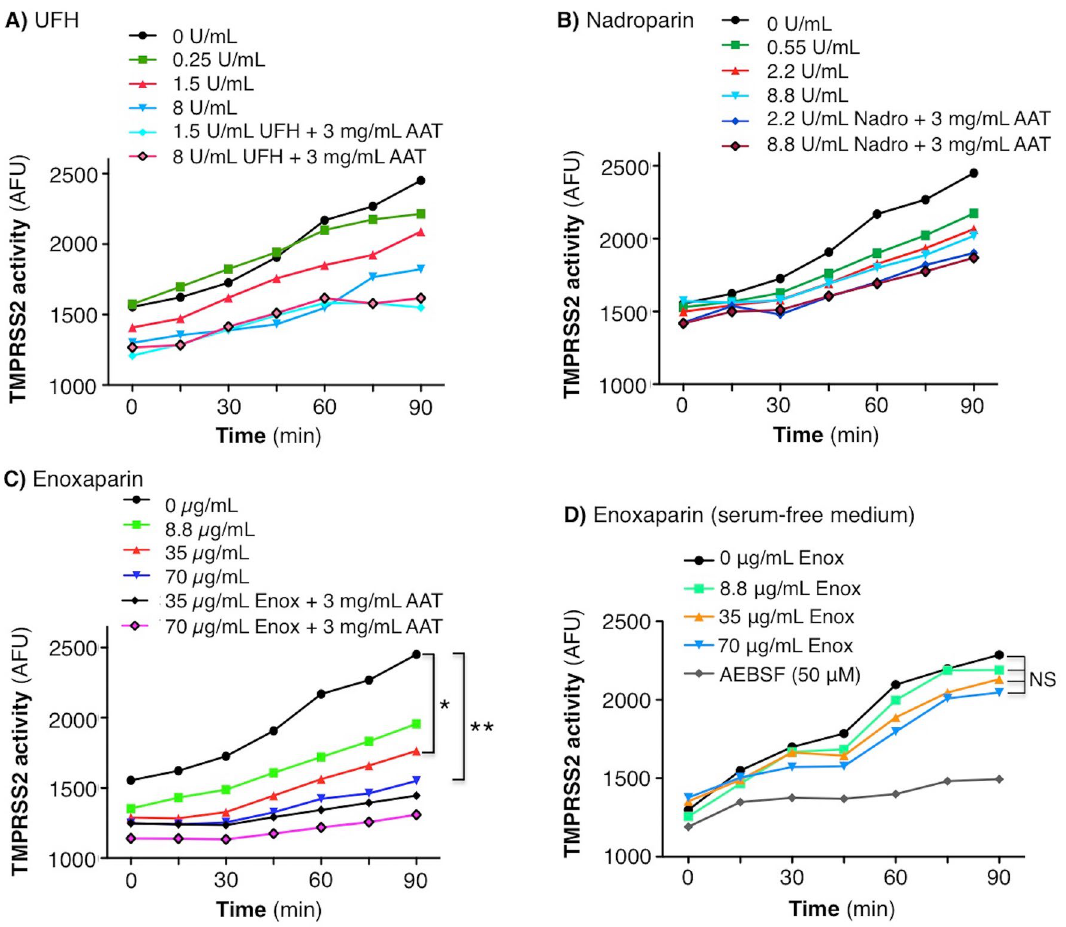
Figure 4. Activity of TMPRSS2 in the presence of UFH, nadroparin, or enoxaparin alone or with AAT. HEK293T TMPRSS2 cells were pre-treated with ( A ) UFH, ( B ) nadroparin, or ( C ) enoxaparin ± AAT at the indicated final concentrations for 30 min, followed by addition of the fluorescent substrate Boc-QAR-AMC. ( D ) HEK293T TMPRSS2 cells were grown in Gibco 293 Serum-free Medium II, pre-treated with enoxaparin at the indicated concentrations for 30 min, followed by addition of Boc-QAR-AMC. Fluorescence was measured immediately on the fluorescent plate reader and then every 15 min for a total of 90 min. Data shown are the mean ± SEM of three independent experiments. *p < 0.05, **p < 0.01 at 90